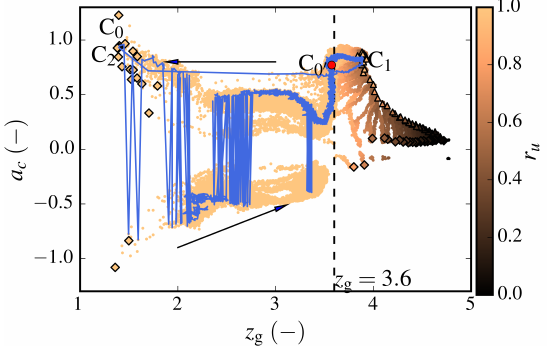
Figure 5: Evolution of the fabric anisotropy a c versus co- ordination number z g during cyclic